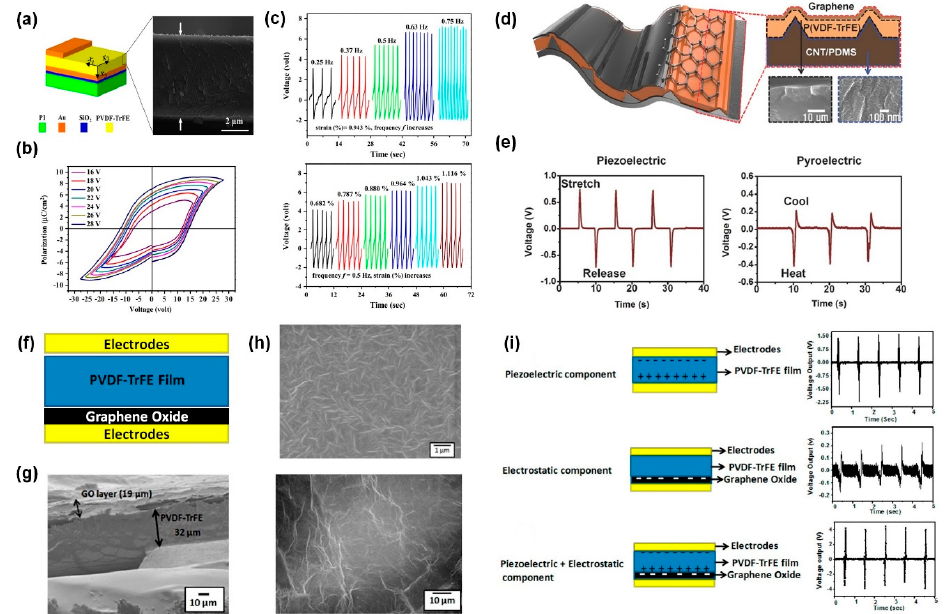
Figure 2. ( a ) A schematic of the thin film piezoelectric nano generator (PENG) and cross-sectional SEM image of a PVDF thin film. ( b ) Polarization versus the applied voltage hysteresis loop of